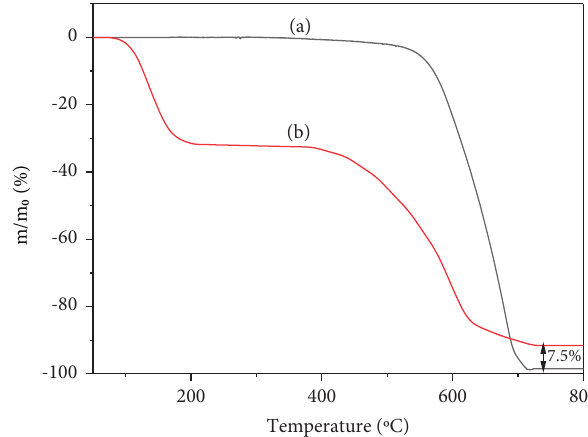
Figure 6: TG analysis of (a) C